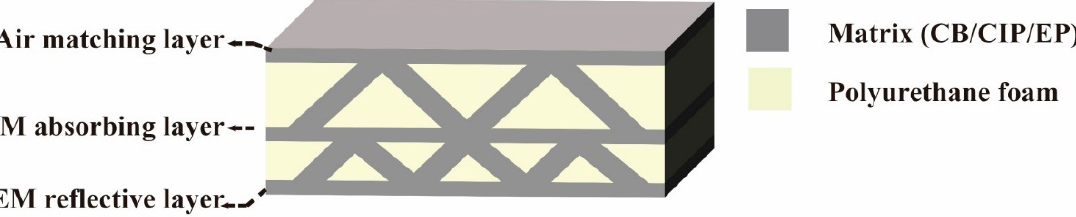
Figure 1. The schematic diagram of the structural design.